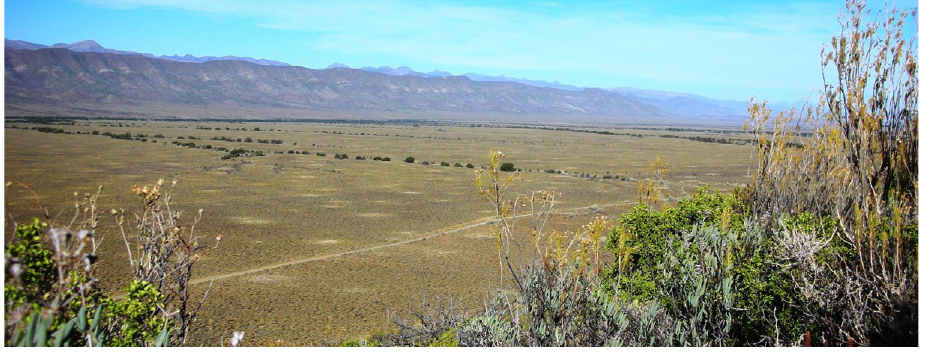
Figure 1: (e.g. hill and riverine areas). This diversity increases and sustains biodiversity and ensures critical eco- system functioning. What would the surface effects of shale gas extraction be on this pristine yet complex